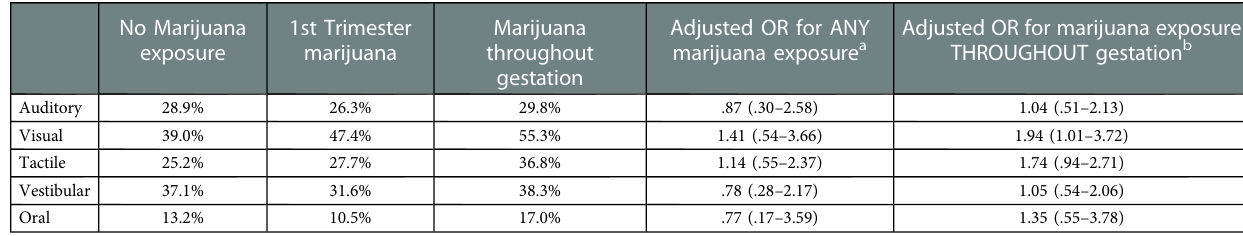
TABLE 2 Rates and adjusted risk of high level of stimulation seeking by sensory domain following prenatal marijuana